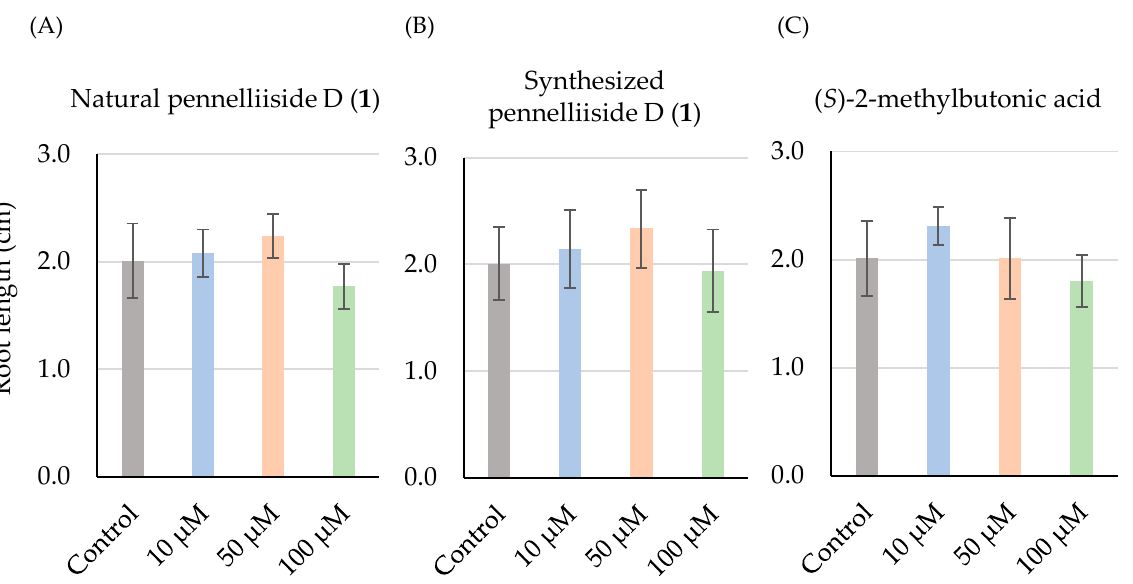
Figure 4. Root growth inhibitory effect of pennelliiside D ( 1 ) and its constituent fatty acids. ( A , B ) root length of natural and synthesized pennelliiside D ( 1 ) and ( C ) root length of ( S )-2-methylbutonic acid. Error bars indicate ± SE ( n = 12; results are from one representative experiment); *: p < 0.05 is significantly different according to Welch’s t -test.